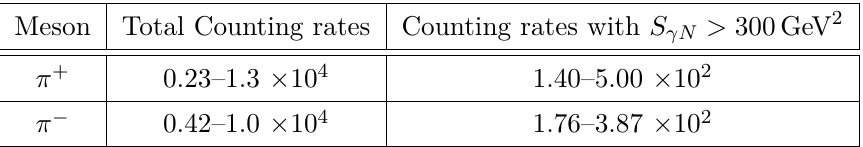
Table 3 . Estimated counting rates at EIC kinematics for π ± γ